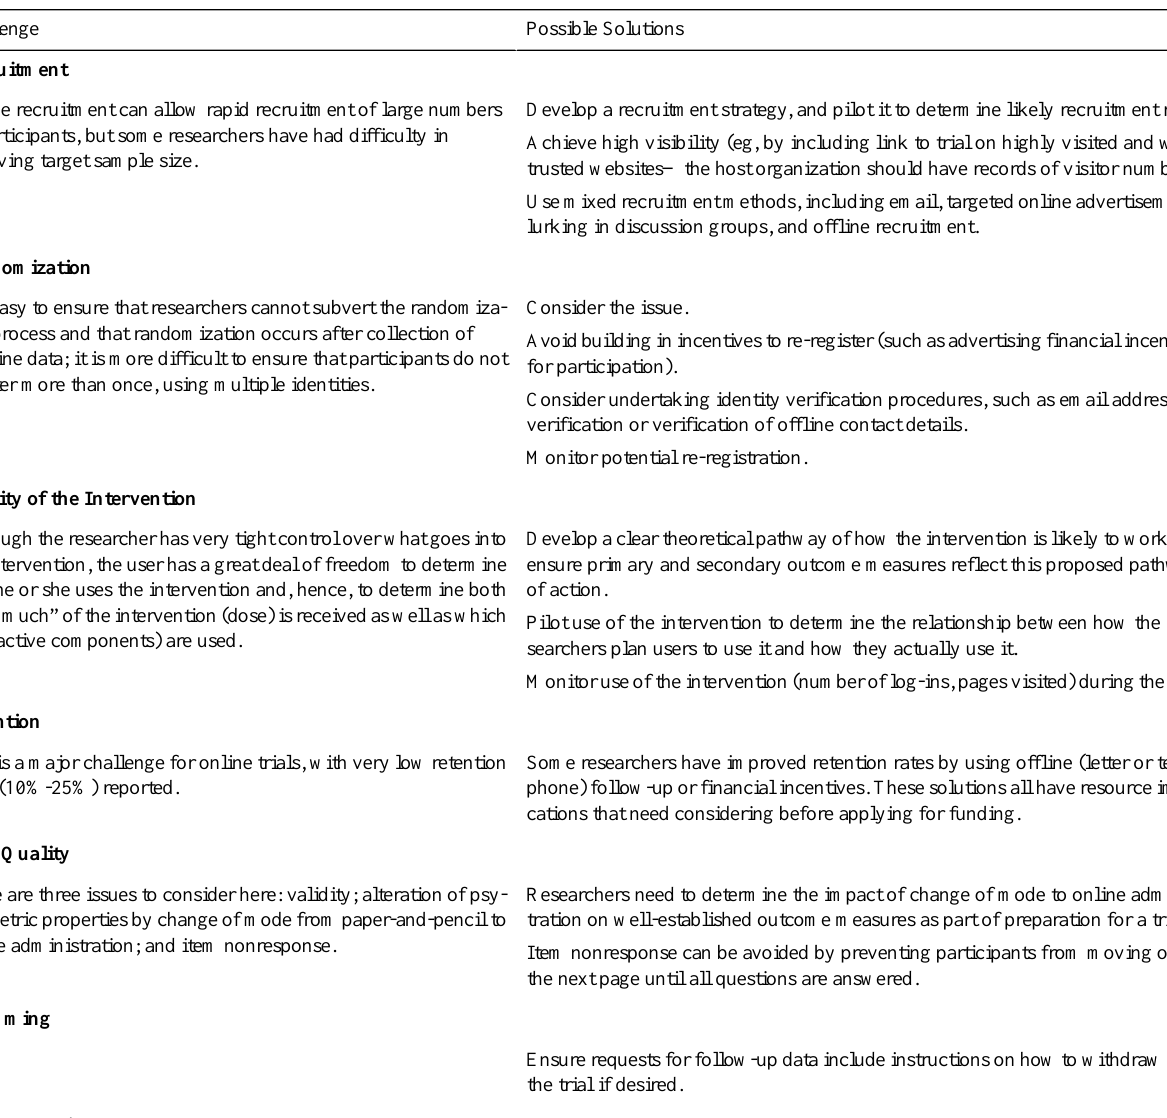
Table 1. Summary of challenges that may arise in online trials and their possible solutions